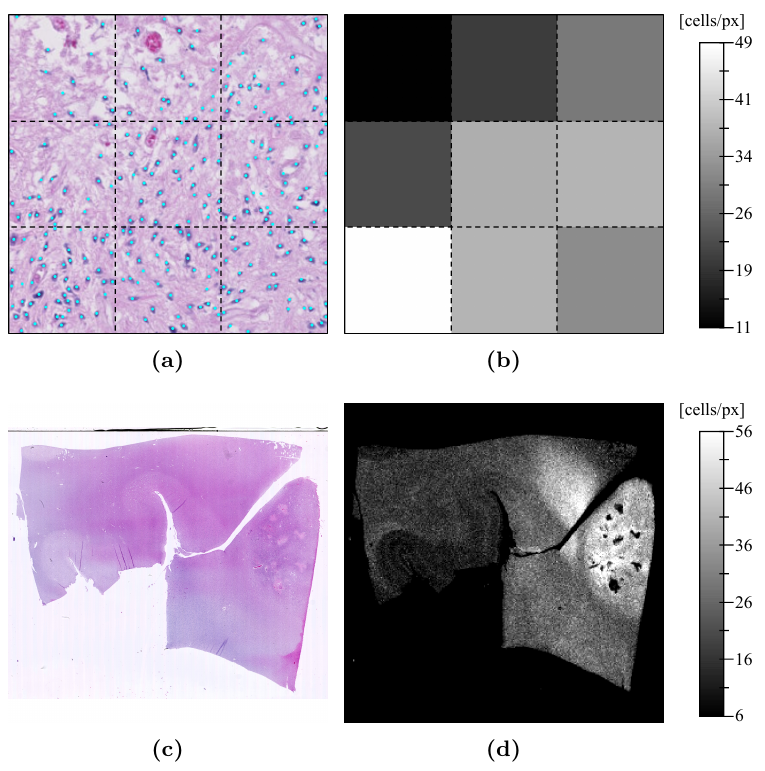
Figure 2. Cell density map computation procedure. ( a ) 3 × 3 adjacent tiles (dotted squares) with di- mensions 100px × 100px and pixel size 1µm × 1µm extracted from the resampled slide in panel ( c ). Cell nuclei detected by the deep convolutional neural network are indicated with cyan dots. ( b ) Cor- responding 3 × 3 pixels (dotted squares) of the cell density map with pixel size 0.1mm × 0.1mm whose value is given by the corresponding tile cell count divided by the true tissue area. ( c ) Whole hematoxylin and eosin stained slide (slide 13, see Table A1). ( d ) Corresponding whole computed cell density